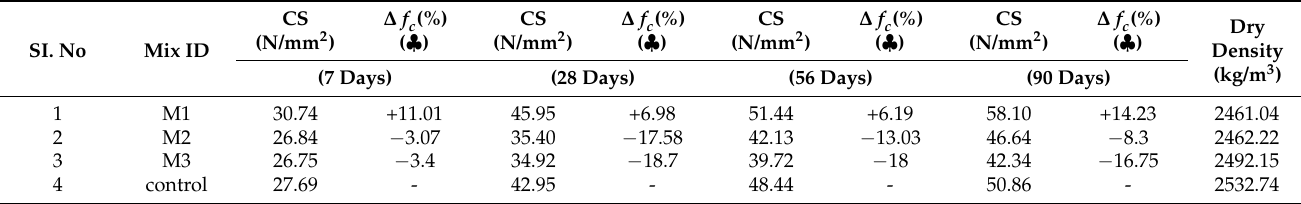
Figure 5. Variation in compressive strength. Table 5. Hardened concrete density and compressive strength.